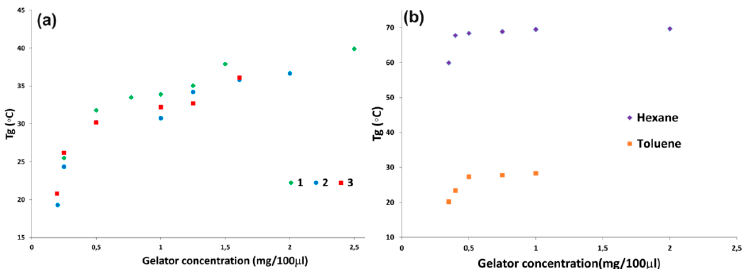
Figure 2. T gel vs. concentration plots as a measure of thermal stability. ( a ) Methanol gels based on triphenylenes 1 , 2 , and 3 ; and ( b ) hydrocarbon gels based on triphenylene amine 6 .